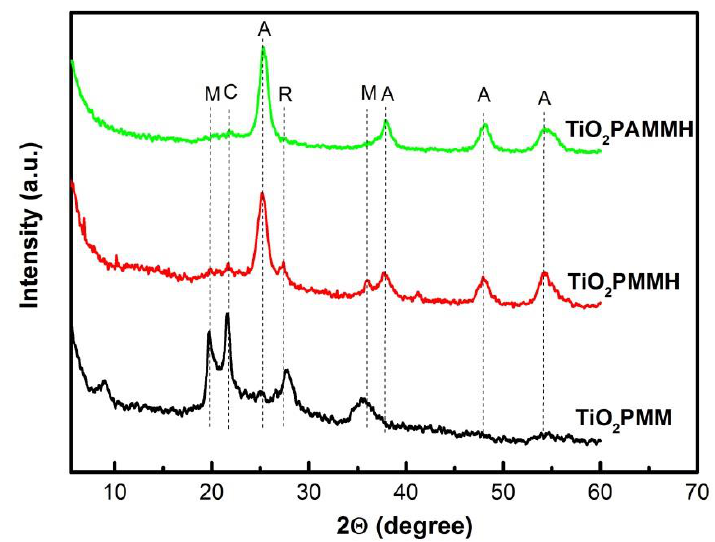
Figure 1. XRD patterns of the TiO 2 -PMM, TiO 2 -PMMH and TiO 2 -PAMMH, where M, C, A and R represent montmorillonite, cristobalite, anatase and rutile phases, respectively.